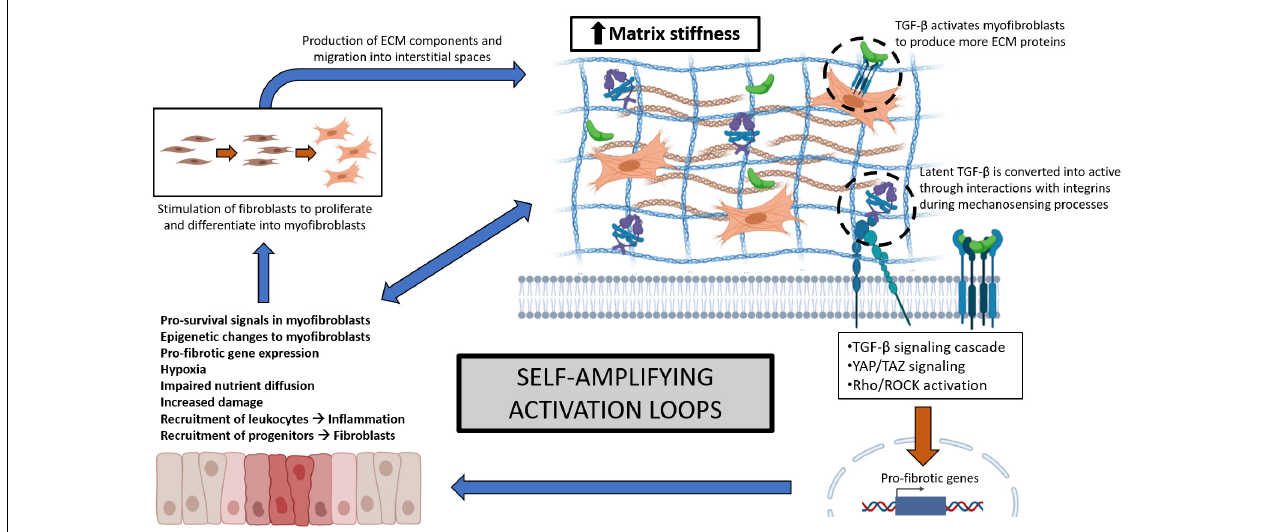
FIGURE 1 | Self-amplifying activation loops involving multiple signaling elements during fibrosis, resulting from increased ECM accumulation and matrix stiffness. Increased tissue stiffness leads to reduced function, hypoxia, and triggers mechanosensory-related transcription factors, causing more damage, pro-fibrotic gene expression, and fibroblast activation and differentiation into myofibroblasts. Myofibroblasts contribute to ECM synthesis and accumulation and are supported by pro-survival signals and epigenetic changes to further enhance fibrosis. These self-amplifying mechanisms are conserved across different organ